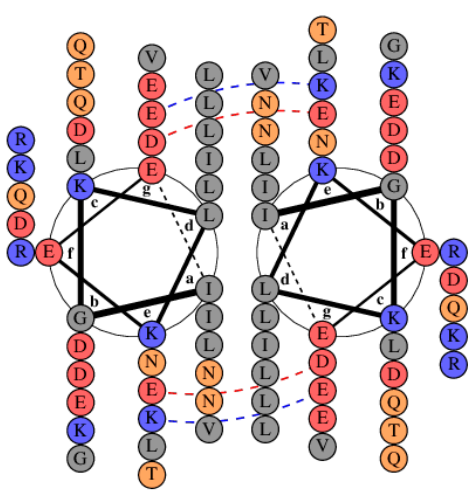
Figure 6. Helical wheel representation of Par-4 leucine zipper parallel dimer (DrawCoil 1.0, Dartmouth College, Hanover, NH, USA). Basic residues are blue and acidic residues are red. The red dashed line represents inter-helical charge repulsion and the blue dashed line represents an inter-helical salt bridge.